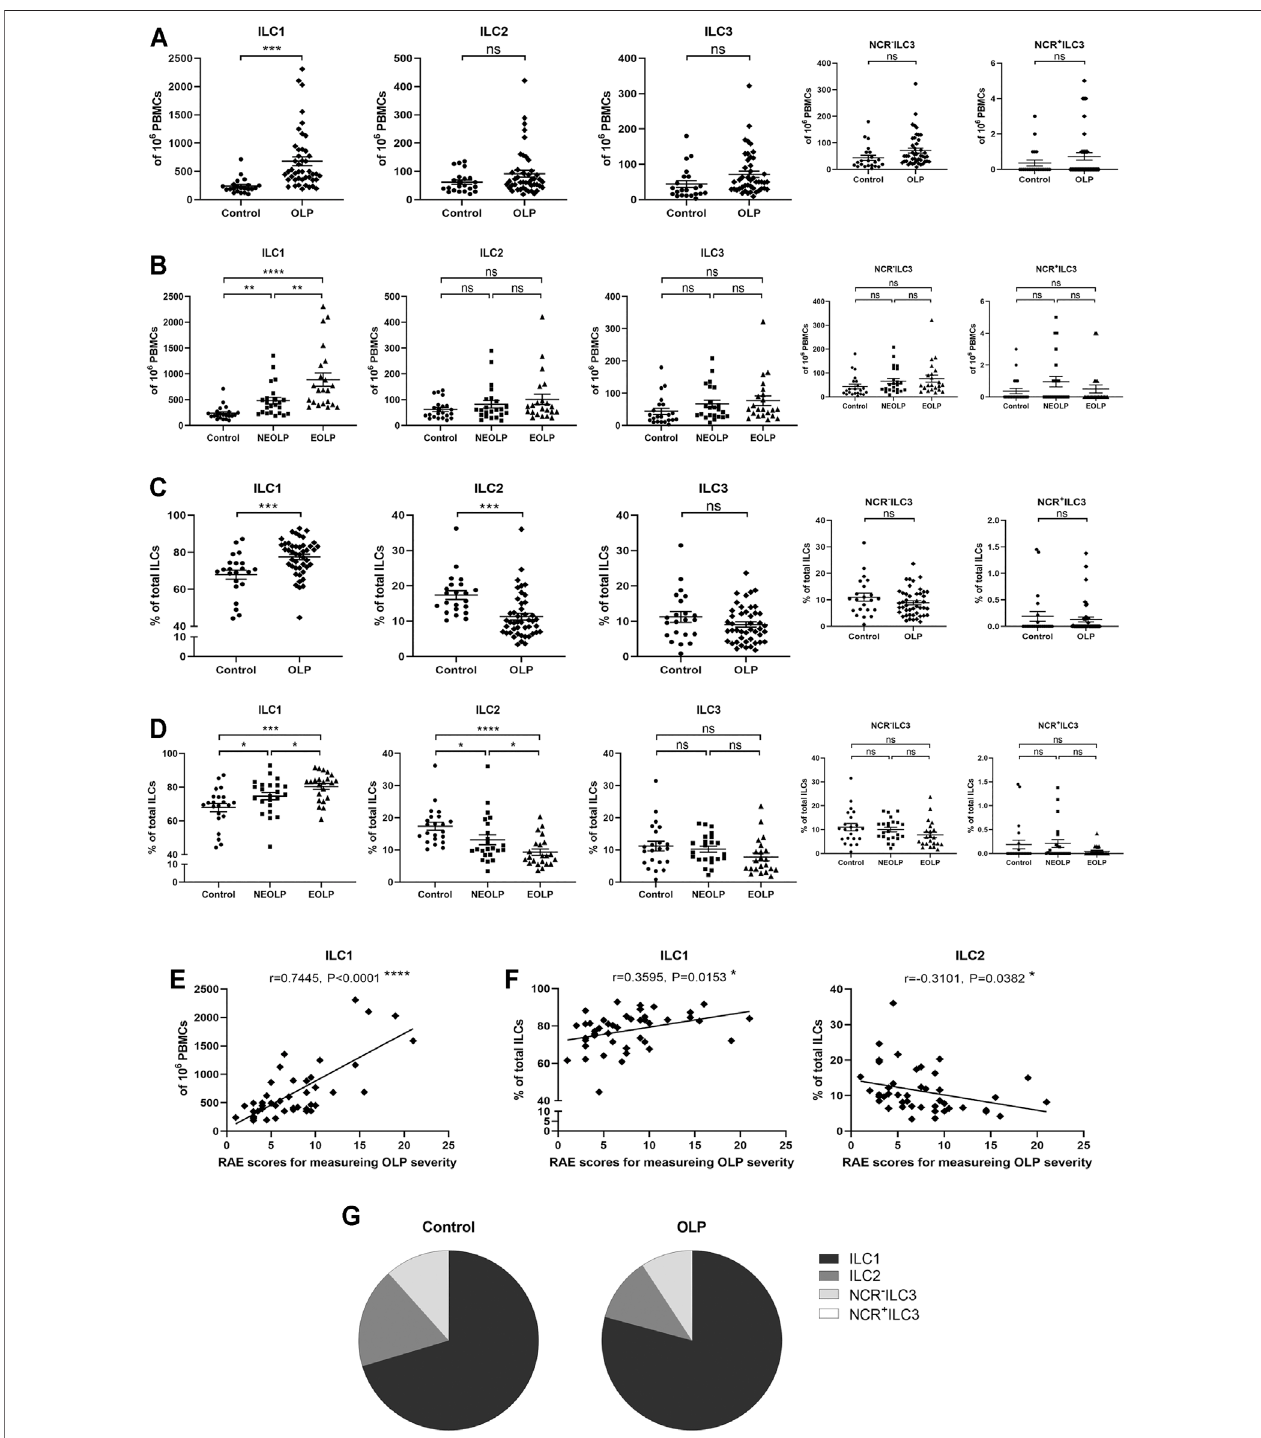
FIGURE 2 | Distribution of ILC subpopulations. (A,B) The absolute numbers of ILC1s, ILC2s, and ILC3s (NCR − ILC3s & NCR + ILC3s) in 10 6 PBMCs. (C,D) The proportionsofILC1s,ILC2s,andILC3s(NCR − ILC3sandNCR + ILC3s)intotalILCs.CorrelationsofILC1countsintotalPBMCs (E) aswellasILC1andILC2proportions in total ILCs (F) withcorresponding disease severity inOLP. (G) ILC distribution pie charts present theaverage percentage ofeach ILC subpopulation in total ILCs ofthe control group and OLP group. ILC, innate lymphoid cell; PBMCs, peripheral blood mononuclear cells; OLP, oral lichen planus.